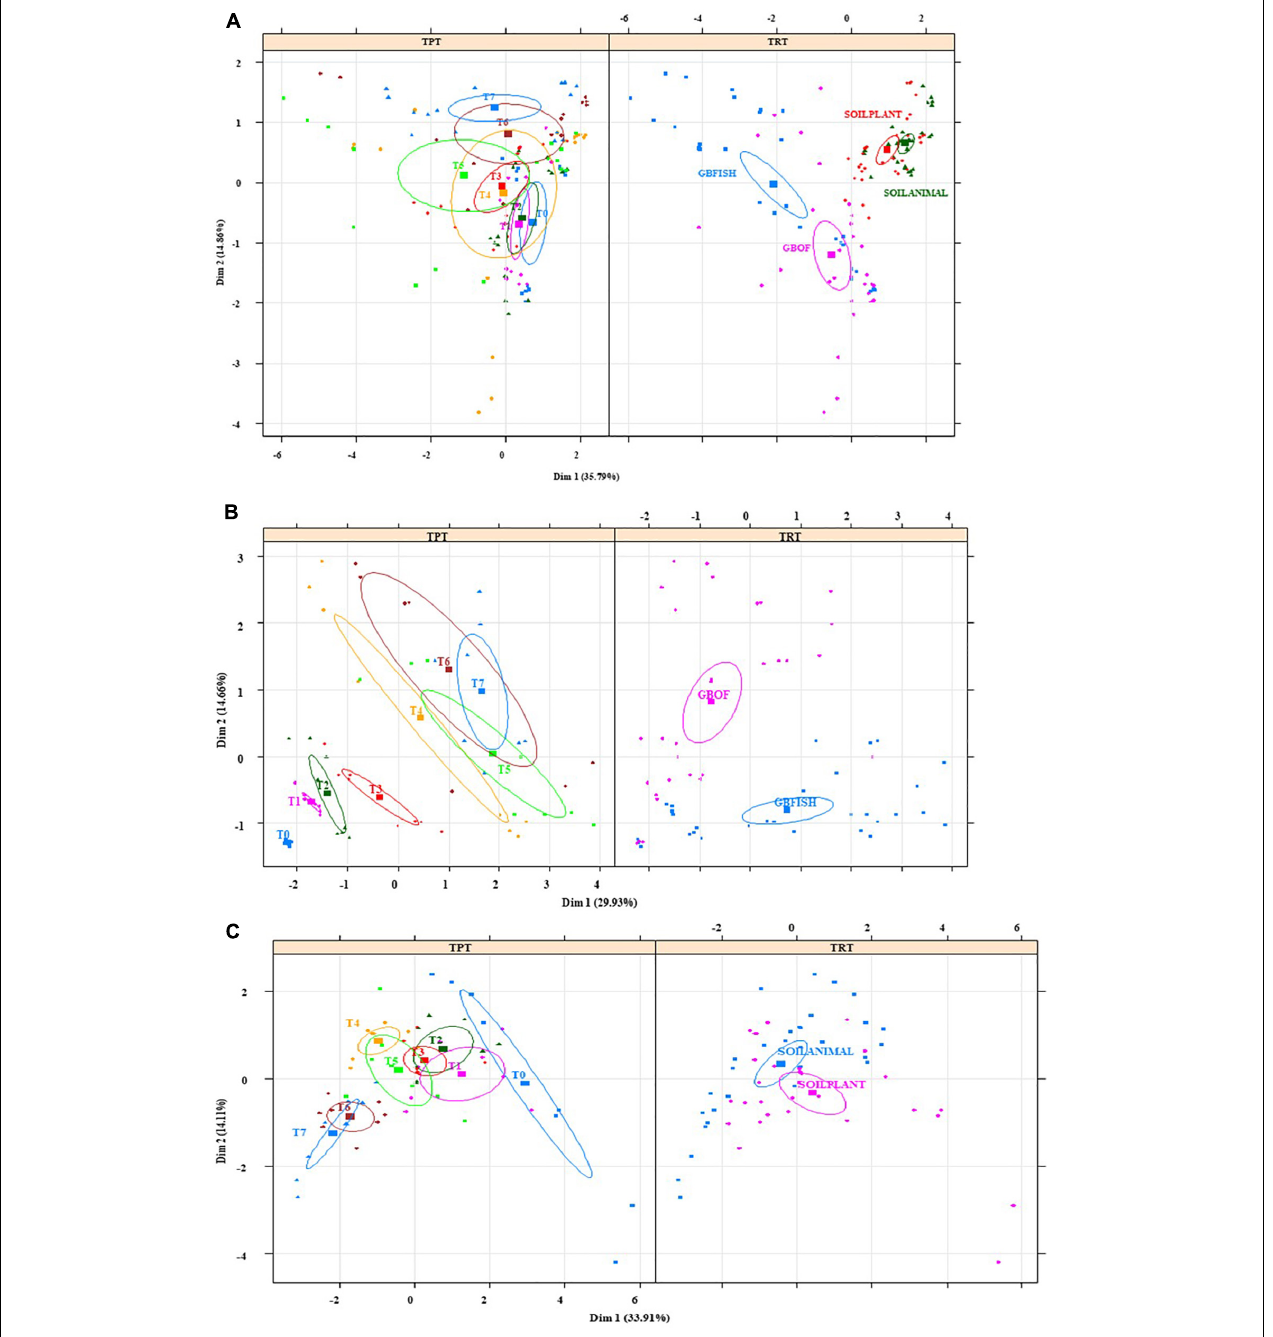
FIGURE 10 | Multiple factor analysis in which 20 of the most significant factors were taken into account for the four contrasting culture systems (A) , organic soil (B), and for the soilless culture system (C) . TRT indicates the tomato cultivating system (GBOF, organic growing medium with organic fertilizers; GBFISH, organic growing medium with fish effluent; SOILANIMAL, organic soil that was fertilizer with animal-derived material; and SOILPLANT, soil that was fertilized with plant-derived material). TRT, time point. Samples for microbial community analysis were taken at 8 different timepoints, i.e., 55 DAS (T0), 68 DAS (T1), 83 DAS (T2), 113 DAS (T3), 146 DAS (T4), 172 DAS (T5), 221 DAS (T6), and 321 DAS (T7). Circles indicate the 95% confidence